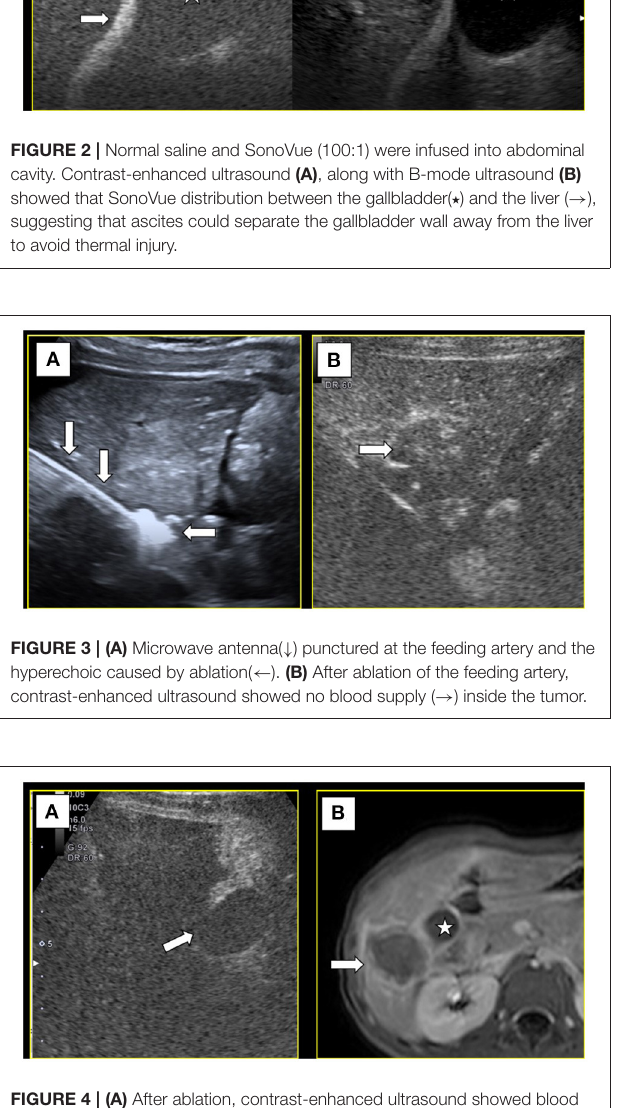
FIGURE 4 | (A) After ablation, contrast-enhanced ultrasound showed blood supply in gallbladder wall ( → ), suggesting the gallbladder wall had no necrosis. (B) Magnetic resonance imaging 1 month later showed the lesion was completely ablated ( → ) and the gallbladder( ⋆ ) was not